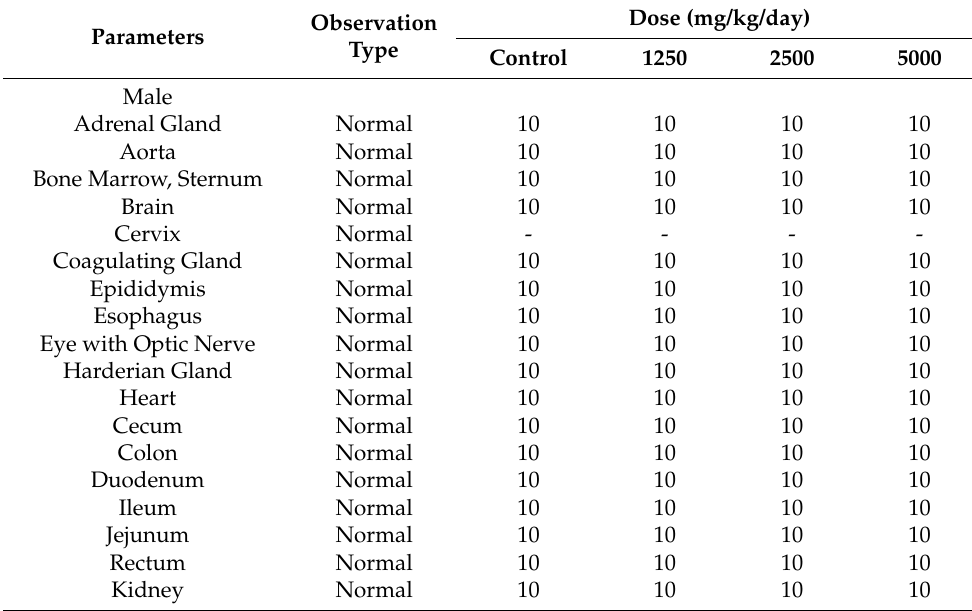
Table 13. Necropsy findings in 13 weeks repeated oral dose toxicity of WG extract in male rats.